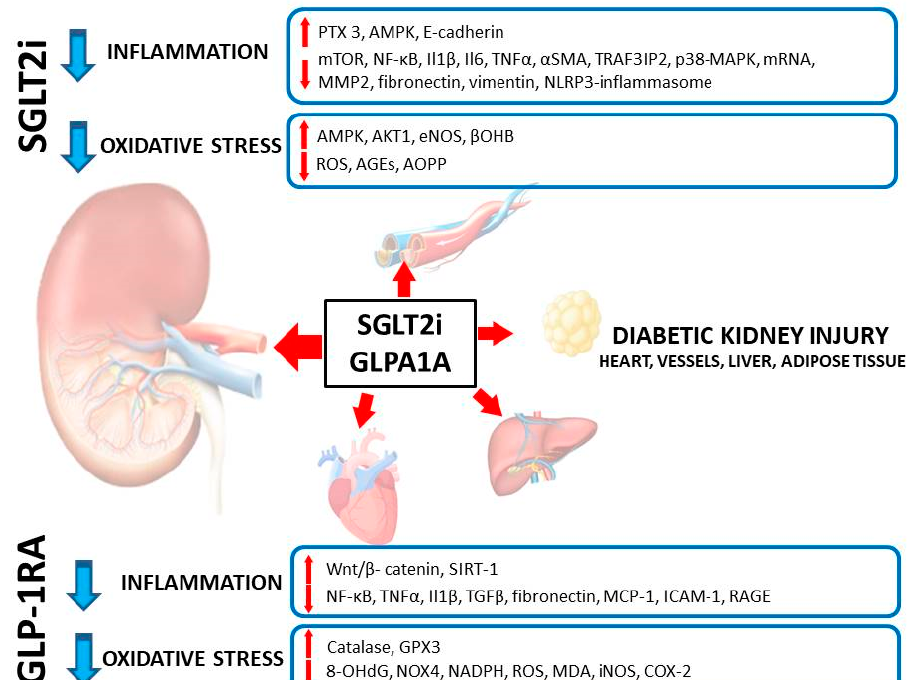
Figure 2. Selected mechanisms of interaction between SGLT2i, GLP1RA and inflammation/oxidative stress in the kidney and other target organs/tissues. Legend to Figure 2: 8-OHdG — 8-Hydroxy-deoxyguanosine; AGEs — Advanced glycation end products; AKT1 — AKT Serine/threonine kinase 1; AMPK — 5 ′ AMP-activated protein kinase; AOPP — Advanced oxidation protein products; COX-2 — Cyclooxygenase-2; eNOS — Endothelial nitric oxide synthase; GPX3 — Glutathione Peroxidase 3; ICAM-1 — Intercellular adhesion molecule 1; Il1 β — Interleukin1 β ; Il6 — Interleukin 6; iNOS — Inducible nitric oxide synthase; MCP-1 — Monocyte chemoattractant protein-1; MDA — malondialdehyde; MMP2 — Matrix metalloproteinase-2; mRNA — messenger RNA; mTOR — Mammalian target of rapamycin; NADPH — Nicotinamide adenine dinucleotide phosphate; NF- κ B — nuclear factor kappa-light-chain-enhancer of activated B cells; NLRP3-inflamassome — NOD-, LRR- and pyrin domain-containing protein 3 inflammasome; NOX4 — NADPH Oxidase 4; p38-MAPK — p38 Mitogen-activated protein kinase; PTX 3 — Pentraxin 3; RAGE — Receptor for advanced glycation end products; ROS — Reactive oxygen species; SIRT — Sirtuins; TGF β — Transforming growth factor β ; TNF α — tumor necrosis factor α ; TRAF3IP2 — Tumor necrosis factor receptor associated factor 3 interacting protein 2; α SMA- α -Smooth muscle actin; β OHB — β -Hydroxybutyric acid.